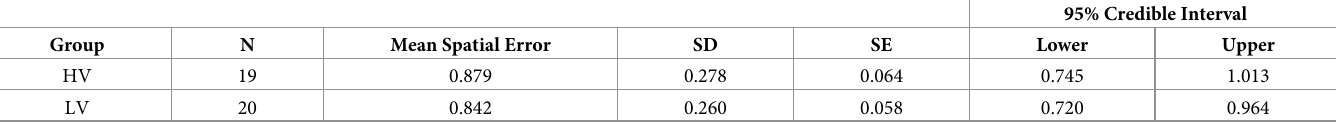
Table 2. Descriptive statistics. Descriptives of the comparison of mean spatial error in HV and LV group of Experiment 3, by means of a Bayesian independent t-test.